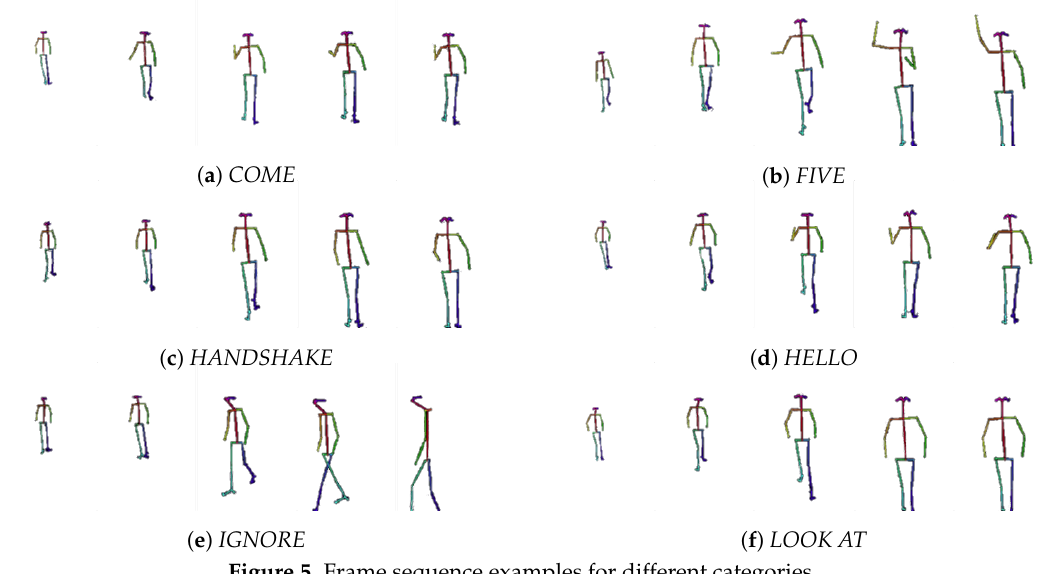
Figure 5. Frame sequence examples for different